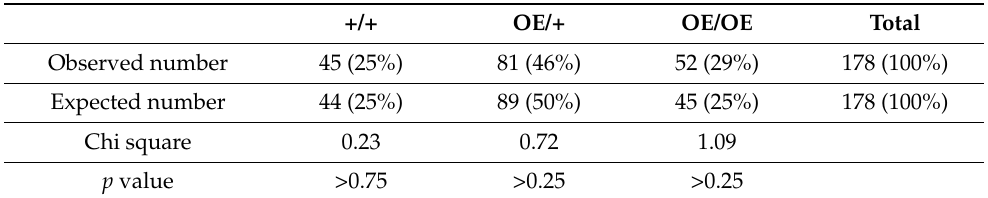
Table 1. Mendelian ratios of the respective number of adult mice collected from the intercrossing of heterozygotes Usp22 OE/+ are as expected.